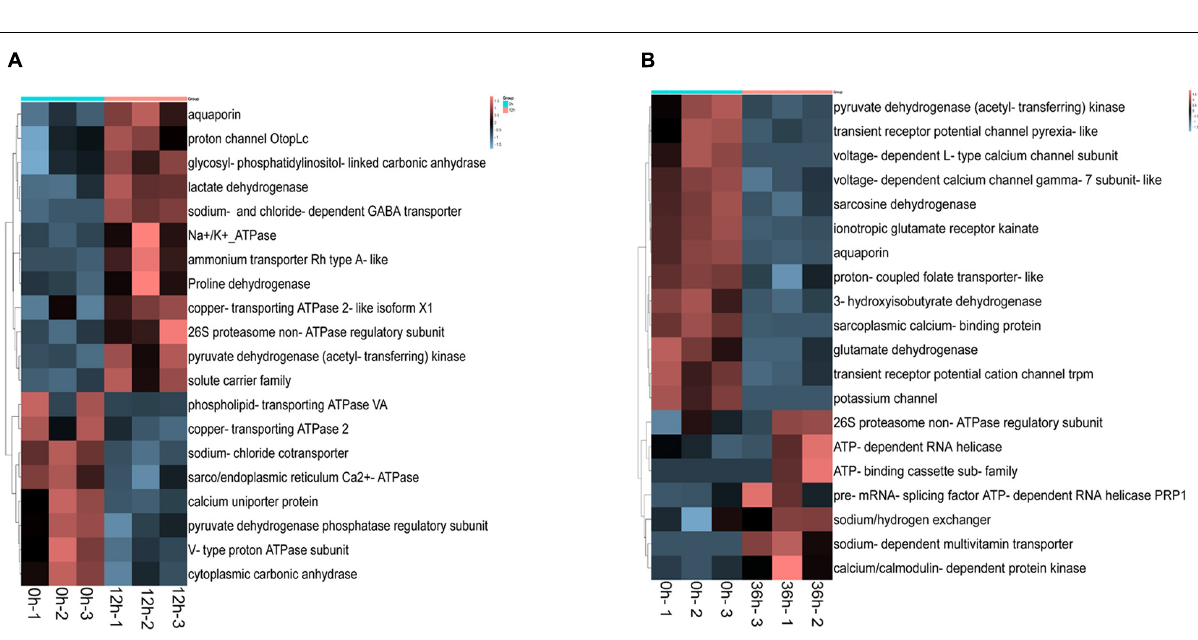
Frontiers in Marine Science |